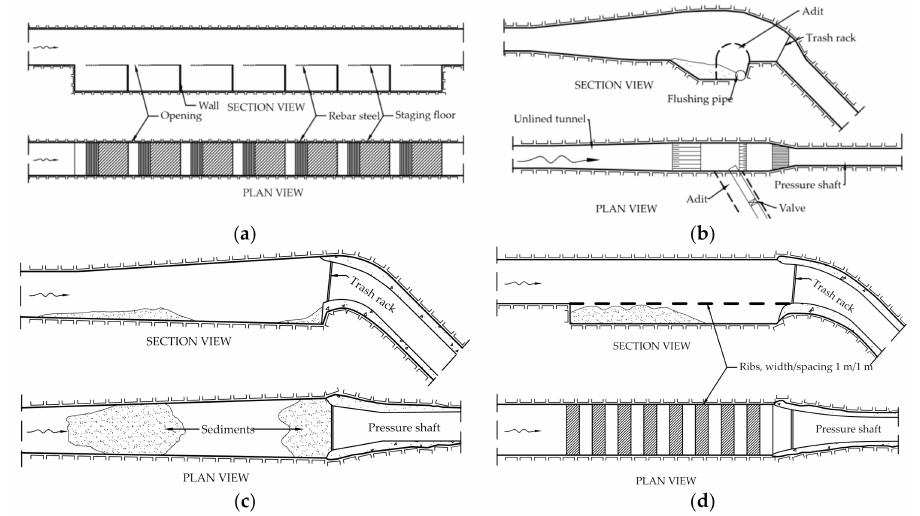
Figure 4. ( a ) CELSEP rock trap (Adapted with permission from [41]. Copyright 1964 ASCE), ( b ) obsolete rock trap, ( c ) open rock trap, ( d ) closed rock